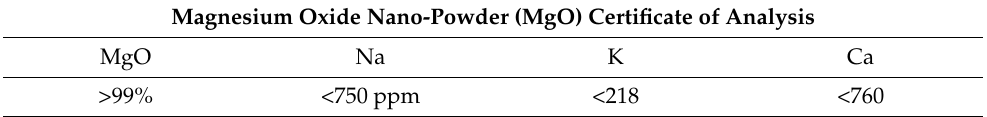
Table 4. Chemical properties of nano-powder.